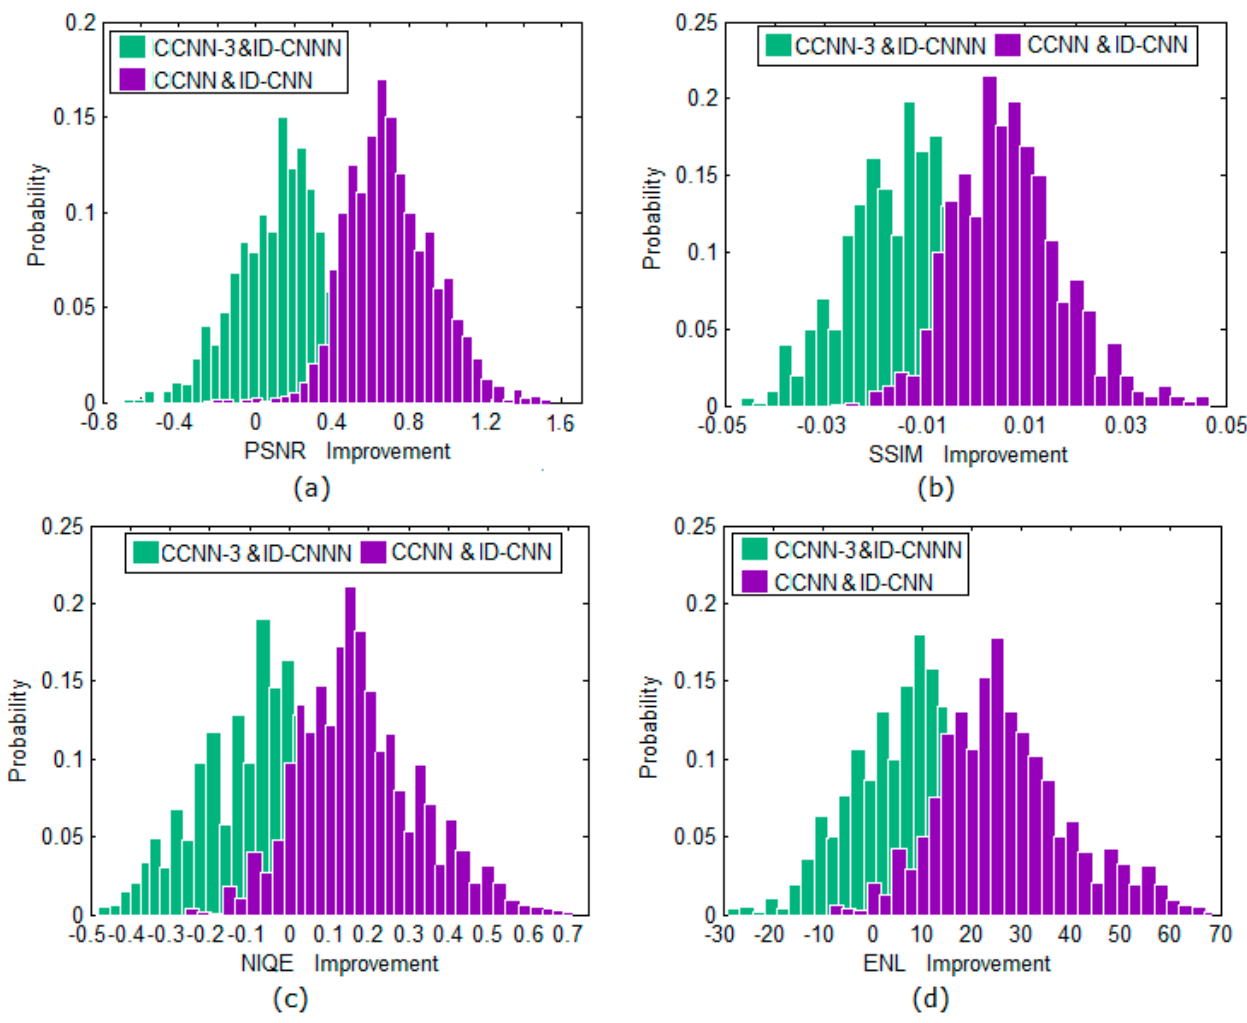
Figure 4. Probability distributions of the PSNR, SSIM, NIQE and ENL gains for the 100 synthetic and 100 real SAR images. ( a ) PSNR; ( b ) SSIM; ( c ) NIQE; ( d ) ENL.